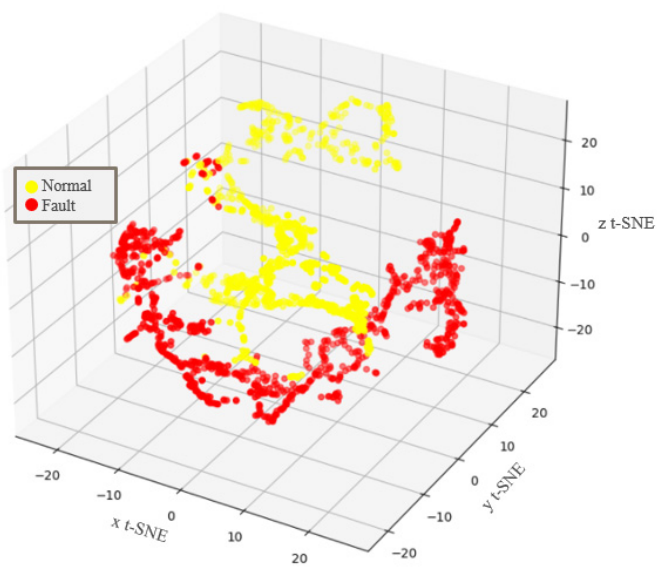
Figure 11. 3D t-SNE feature visualization result. The axes of t-SNE define a 3D space into which the higher dimensional space will be projected, preserving relative proportional distances.